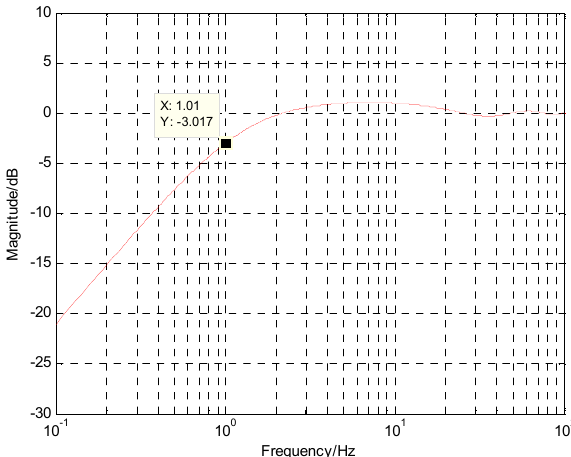
Figure 7. The simulation of the performance promotion with EBO.